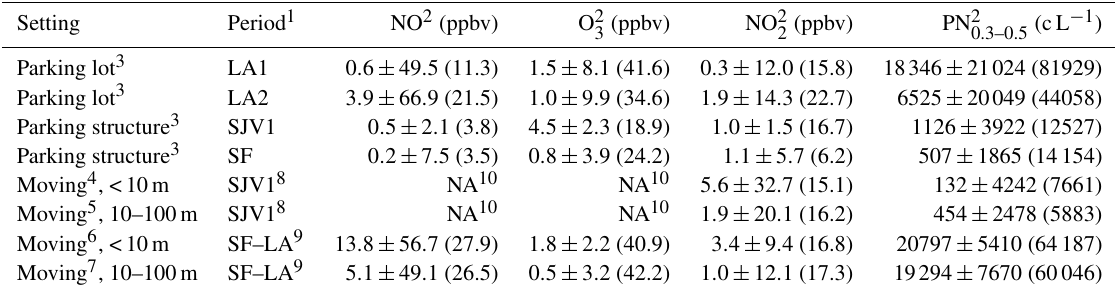
Table 9. Performance summary for measurements reported by collocated vehicles (mean difference ± 1 standard deviation; mean concen- trations in parentheses). Standard deviations are reported here to indicate the variability in the 1s differences. Mean differences provide a measure of average intervehicle differences. For periods when three vehicles were driven, the largest mean difference between vehicles is listed. The signs of the mean differences are not indicated because no vehicle is an audit standard. All values were determined from 1s time resolution